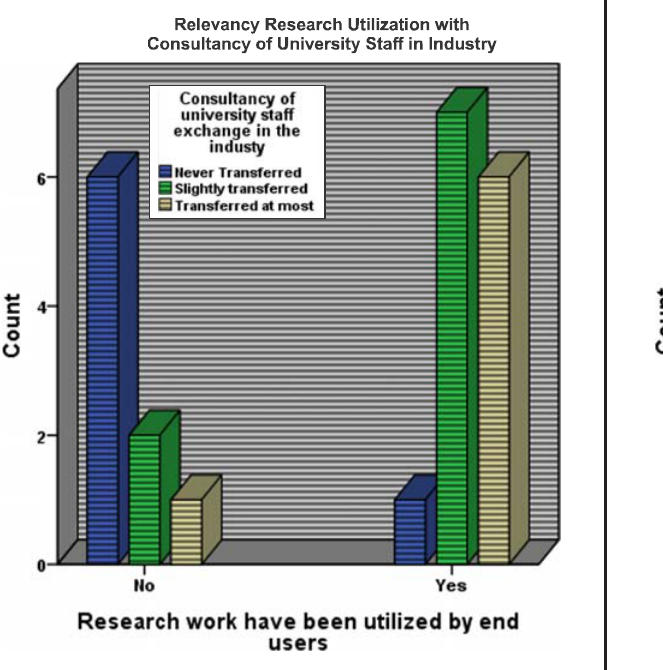
FIG. 6. ROLE OF CONSULTANCY OF ACADEMIC STAFF IN THE INDUSTRY TOWARDS UTILIZATION OF KNOWLEDGE CAPITAL